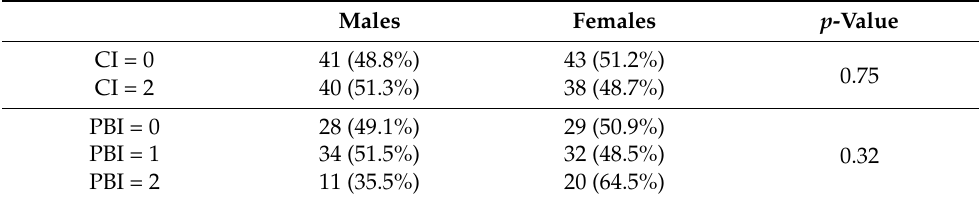
Table 1. Characteristic information of the